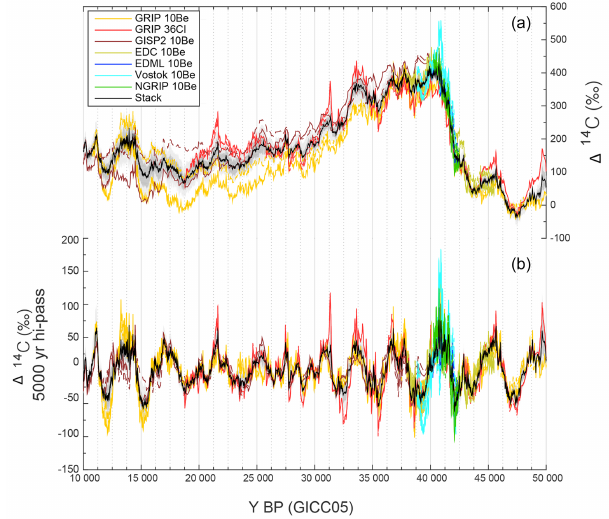
Figure 2. Modeled (cid:49) 14 C anomalies from individual ice-core records (see legend; solid lines are based on radionuclide fluxes, while dashed lines are inferred from flux c ) and the realizations of the ice-core stack (black line shows the mean of all realizations, dark and light grey shading encompass 68.2% and 95.4% proba- bility ranges). (a) The unfiltered model output. (b) The records af- ter variations with frequencies <1 / 5000a − 1 have been subtracted (FFT-based